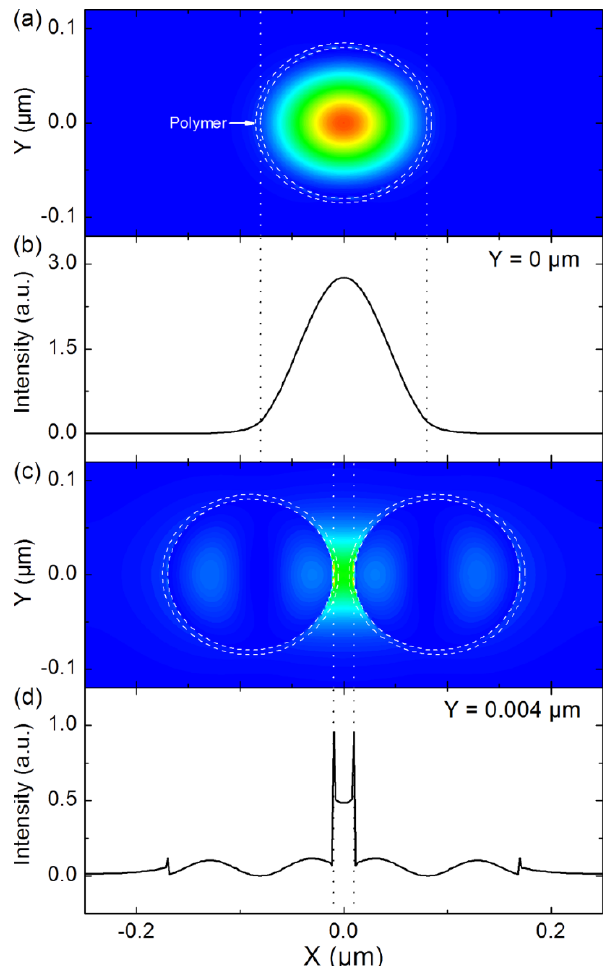
Figure 11. ( a ) Contour map of the Poynting vector amplitude distribution for the guided mode in a ZnO nanorod (defined by the inner dashed circle) with a diameter of 160 nm; ( b ) X-cut at Y = 0 µm for the guided mode profile for the ZnO nanorod; ( c ) Contour map of the Poyting vector amplitude distribution for the gap mode for 2 coupled ZnO nanorods (defined by the inner dashed circles). The coupled nanorods have a diameter of 160 nm and are separated by a 20 nm air gap; ( d ) X-cut at Y = 0.004 µm for the gap mode profile for the coupled ZnO